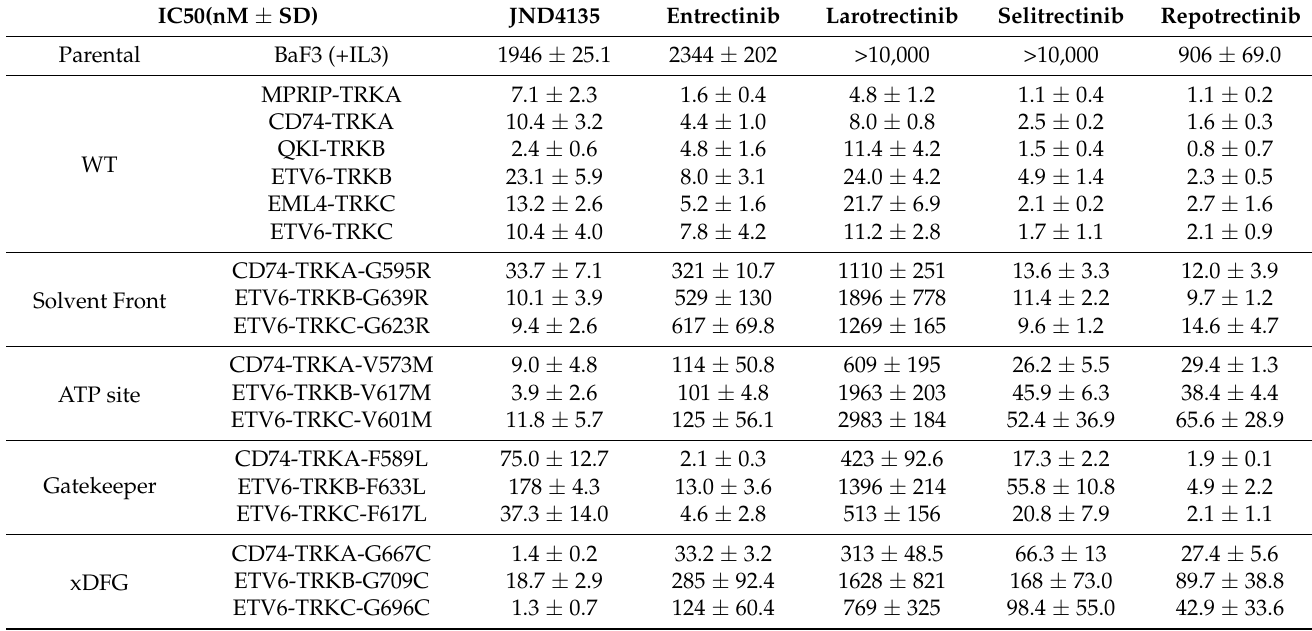
Table 1. JND4135 overcomes a variety of TRK mutations in BaF3 cell proliferation assays. The anti-proliferative activities of the compounds were evaluated using CCK-8 assay. The data were means from at least three independent